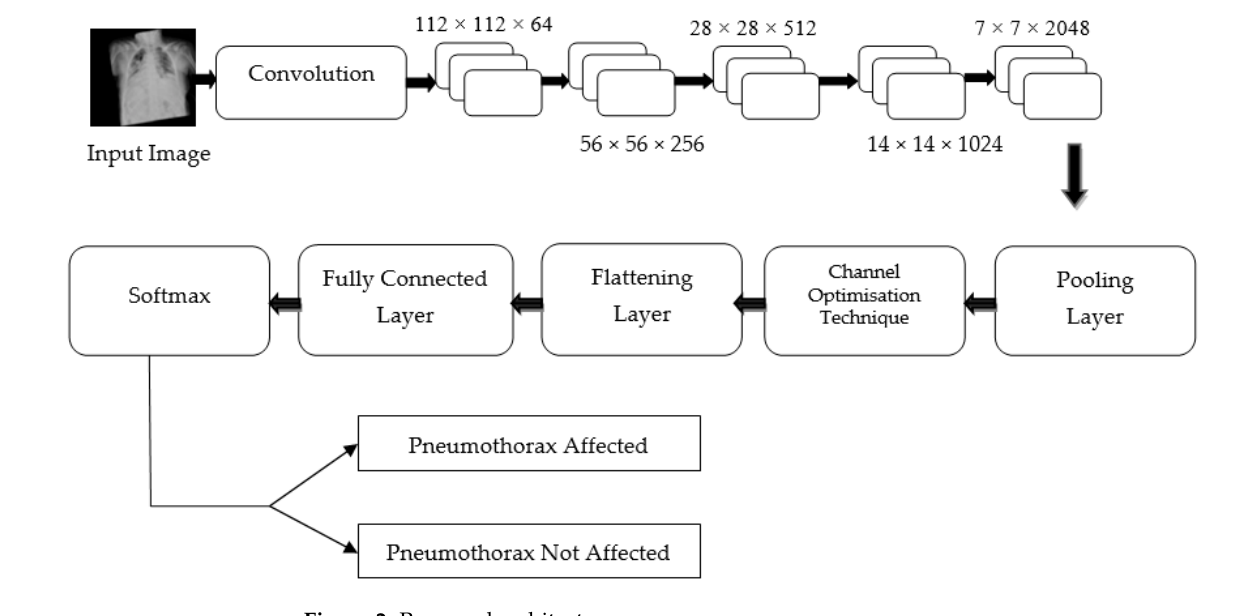
Figure 2. Proposed architecture.